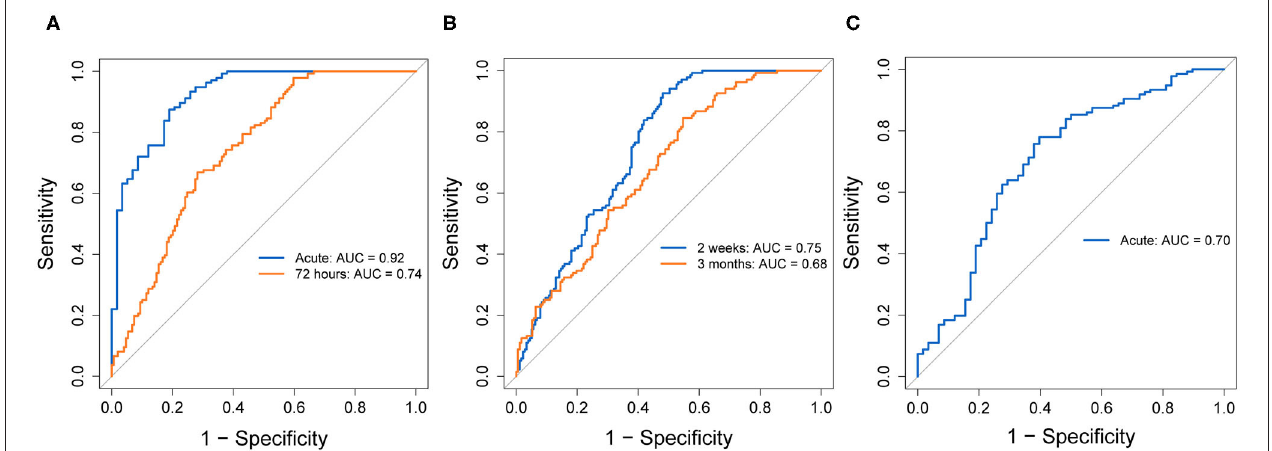
FIGURE 4 | ROC curves indicating diagnostic accuracy of GFAP (A) , NFL (B) , and tau (C) , at selected timepoints, discriminating patients with mTBI from combined controls. ROC curves for each biomarker’s evaluated timepoints are overlain on the same plot. AUC values and their 95% confidence intervals are indicated in each plot, for each timepoint. GFAP, Glial fibrillary acidic protein; NFL, Neurofilament light; ROC, Receiver operating characteristic; AUC, Area under the curve; CI, Confidence interval.